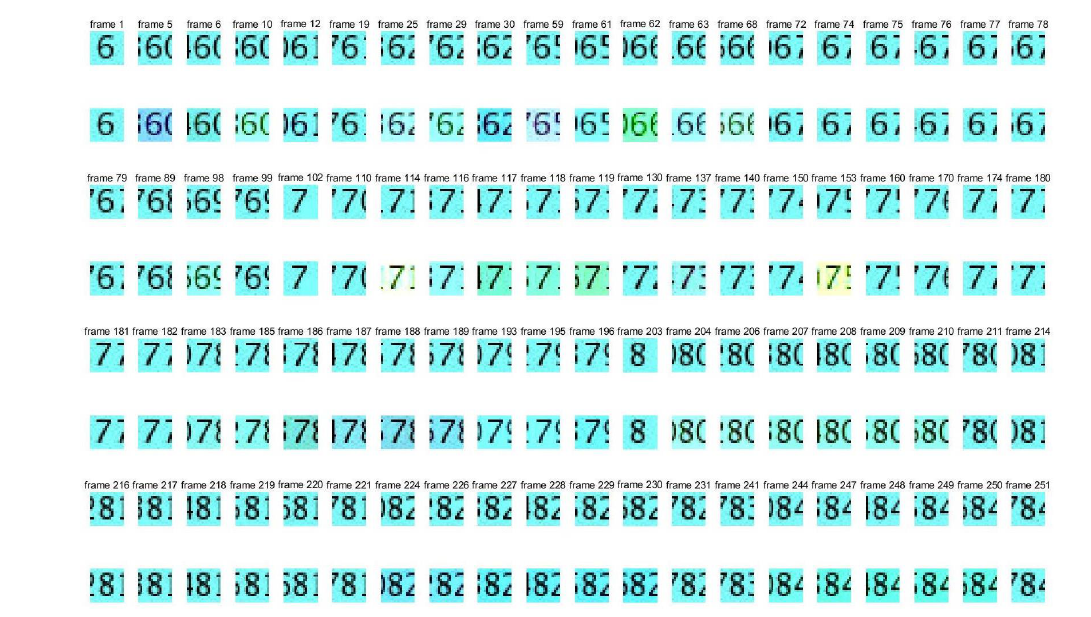
Figure 4. Pictures of watermark 3 and extracted watermark 3. Pictures in the first, third, and fifth lines are the frames in the original watermark video 3, and pictures in the second, fourth, and sixth lines are the frames in the extracted watermark video